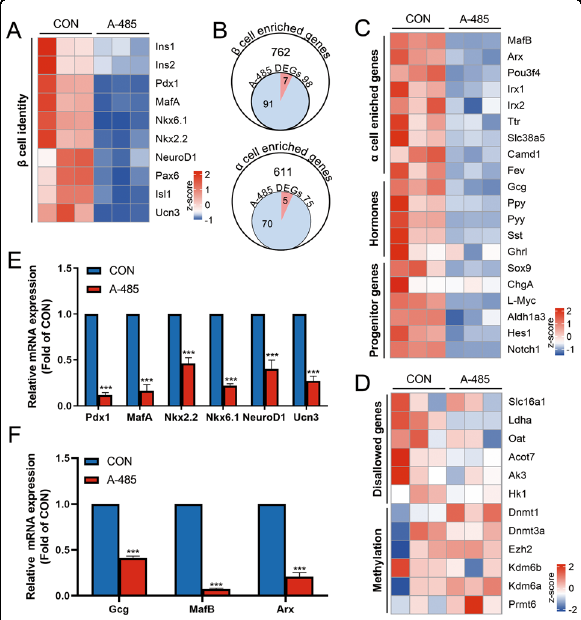
Fig. 2 CBP/p300 HAT inhibition leads to reduced expressions of β and α identity genes. A Heatmap of β cell identity genes. B Venn diagrams of upregulated (red) and downregulated (blue) genes enriched in β and α cell by A-485 treatment. C Heatmap of α cell identity genes, islet hormone genes, and progenitor markers. D Heatmap of disallowed genes and related methylases and demethylases. E – F Isolated rat islets were treated with 3 μ M A-485 for 16 h and mRNA levels of β and α cell identity genes were detected by RT-qPCR. Data are given as mean ± SD for three separate experiments. *** p < 0.001 vs control